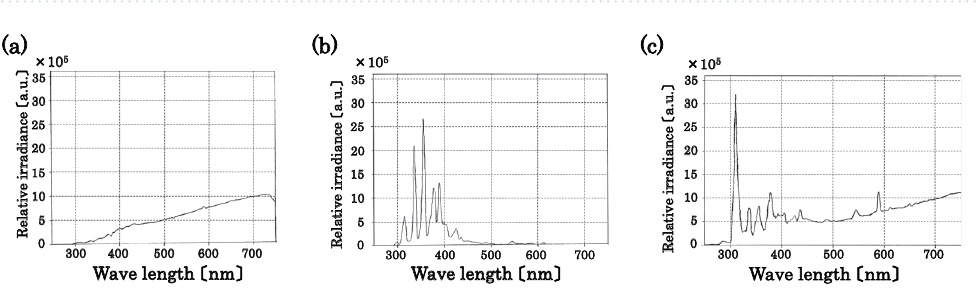
Figure 7. Time series of the discharge current measured via using a clamp on the probe is shown when an ac voltage of 16,500 V is applied and arc discharge occurs. Photographs of the discharge are shown.